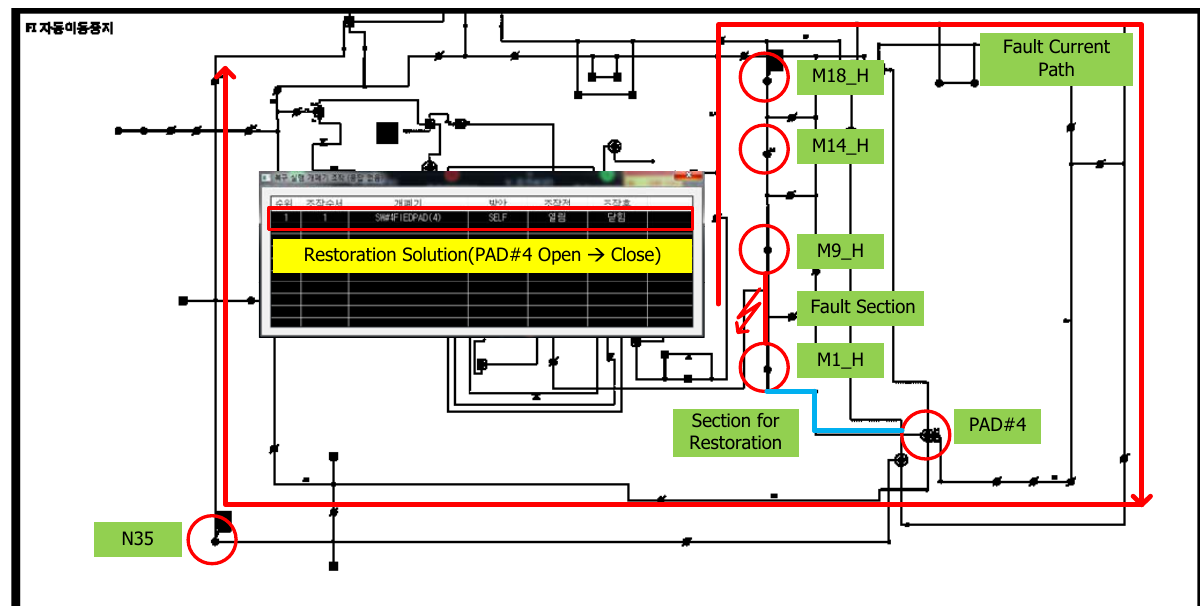
Figure 15. FDIR test